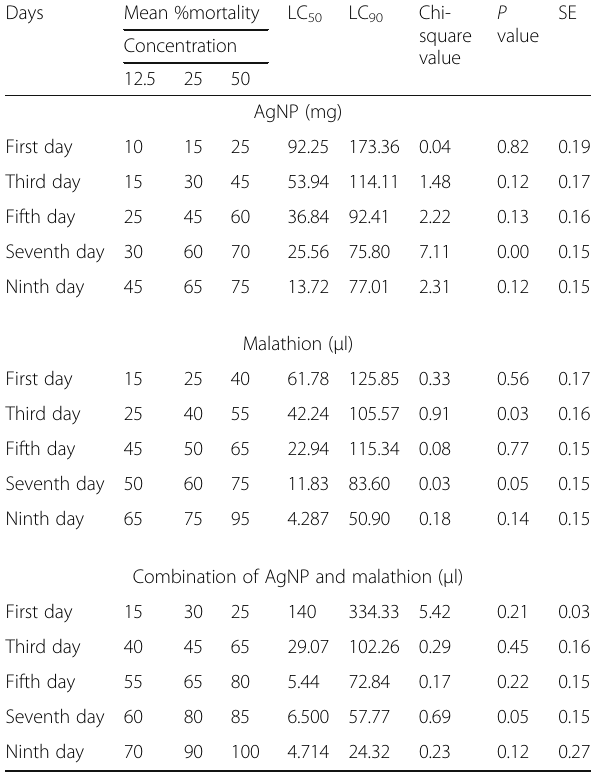
Table 3 Probit analysis for the data on adult mortality of Tribolium castaneum treated with silver nanoparticles, malathion and its combination at 95% confidence limit